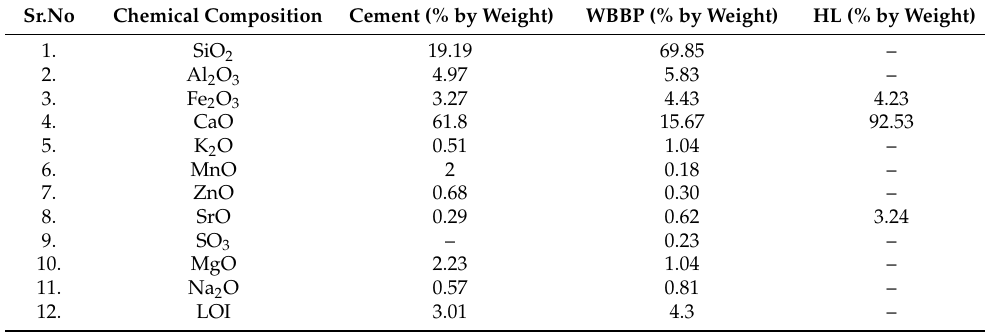
Table 2. Chemical composition of cement, waste burnt brick powder (WBBP), and hydrated lime (HL).